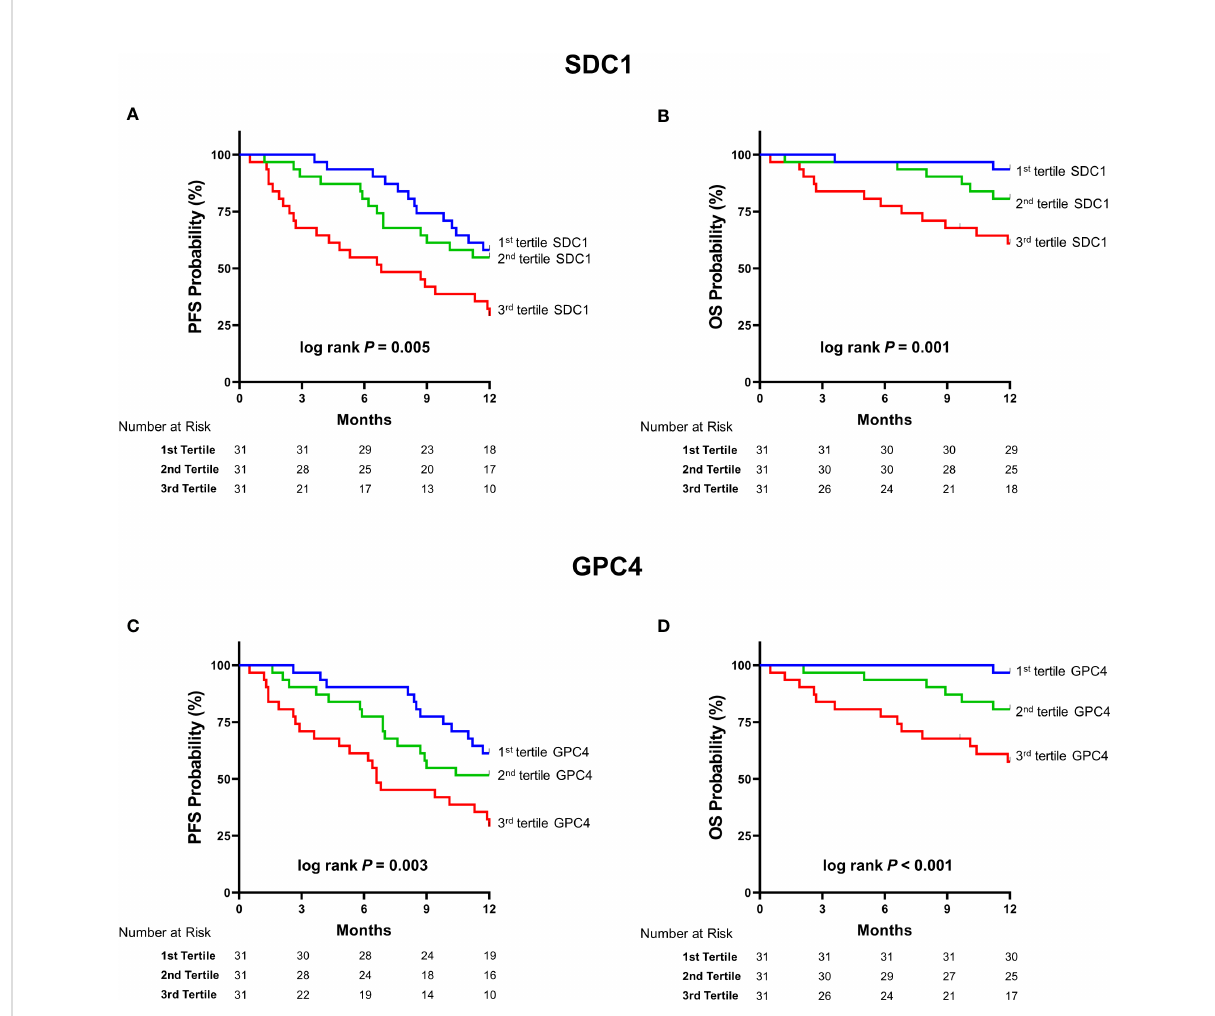
FIGURE 2 Kaplan Meier estimates of survival according to tertiles of SDC1 and GPC4. Kaplan – Meier curves of (A) PFS strati fi ed by tertiles of SDC1 (B) OS strati fi ed by tertiles of SDC1 (C) PFS strati fi ed by tertiles of GPC4 (D) OS strati fi ed by tertiles of OS. P-values were obtained by Log-Rank-Mantel- Cox-tests. SDC1, syndecan-1; GPC4, glypican-4; PFS, progression-free survival; OS, overall